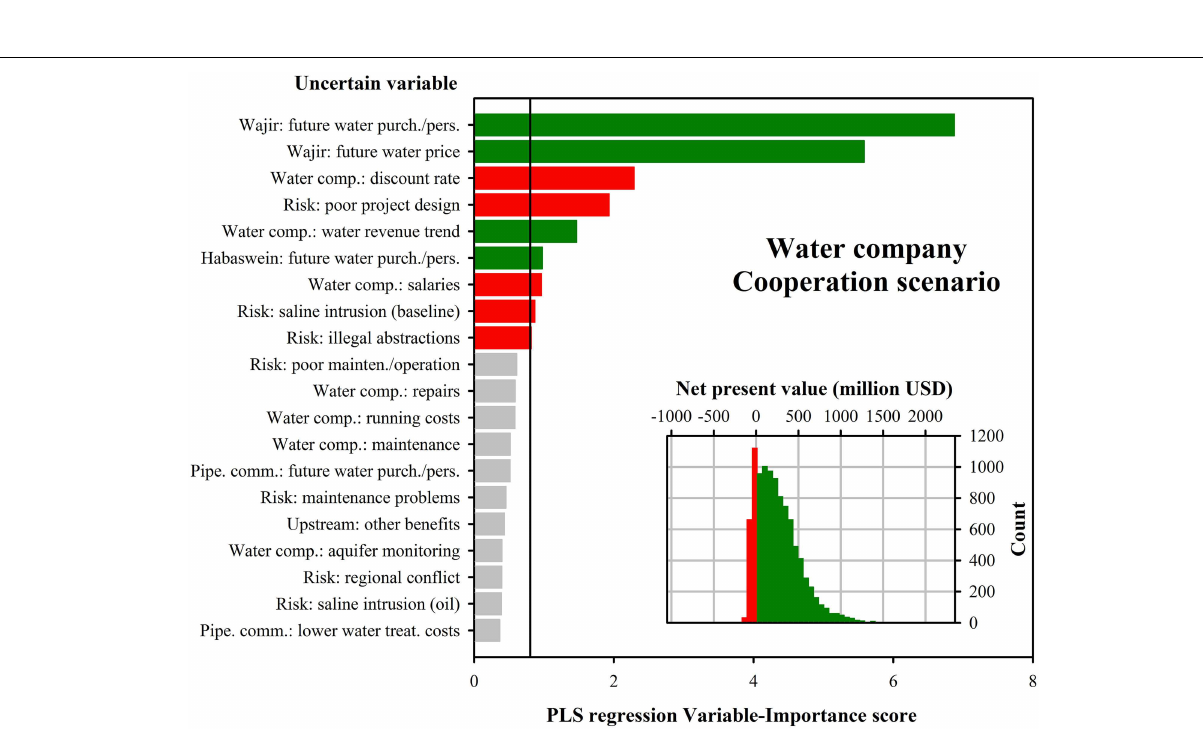
Frontiers in Environmental Science |